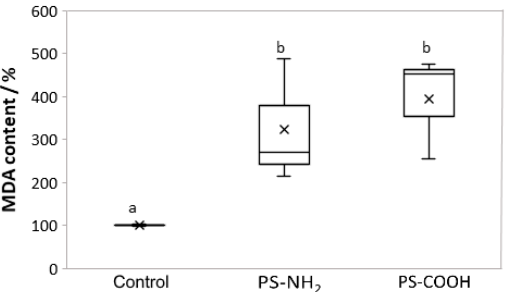
Figure 6. Lipid peroxidation levels in Cylindrotheca closterium when exposed to PS-NH 2 and PS- COOH nanoplastics. Boxplots showing the content of malondialdehyde (MDA) in C. closterium cultures in the exponential growth phase (day 7) exposed to PS-NH 2 NPs (5 µg mL − 1 ) and PS-COOH NPs (200 µg mL − 1 ). Values are expressed as a percentage of control; a box with whiskers represents a median ± interquartile range (Q3–Q1). If the boxes are marked with different letters, the treatments are significantly different at p ≤ 0.05 (a general linear model, followed by a Newman-Keuls post hoc test).